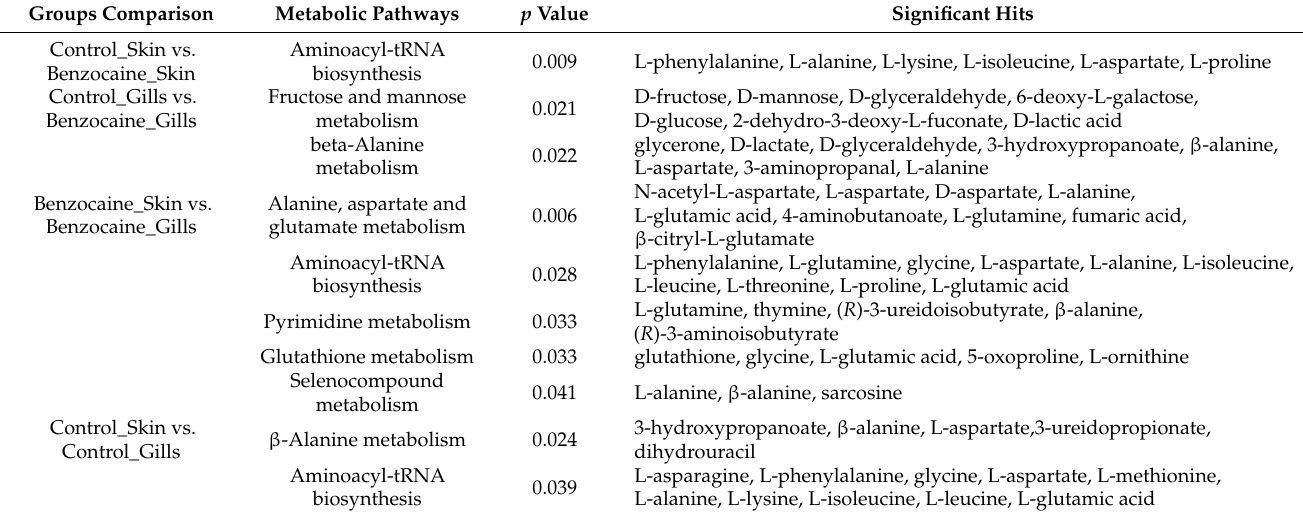
Table 3. The major metabolic pathways that were expressed differently in skin and gill mucus or disturbed due to the exposure to